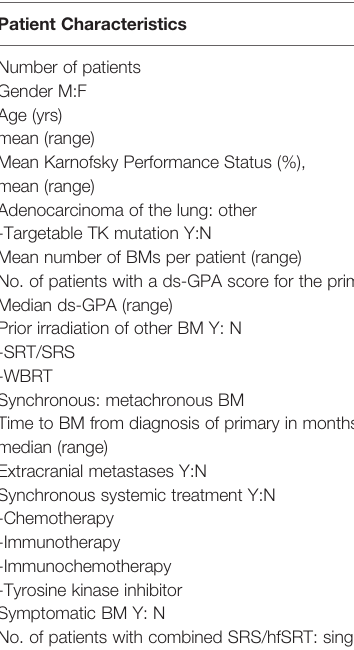
TABLE 1 | Patient